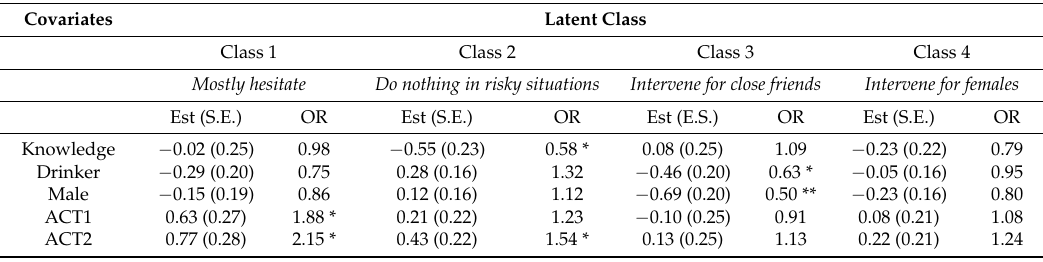
Table 3. Latent Class Regression Estimates of Gender, Knowledge, Drinking Status and Reaction to Own Flushing using Class 5 ( always intervene ) as